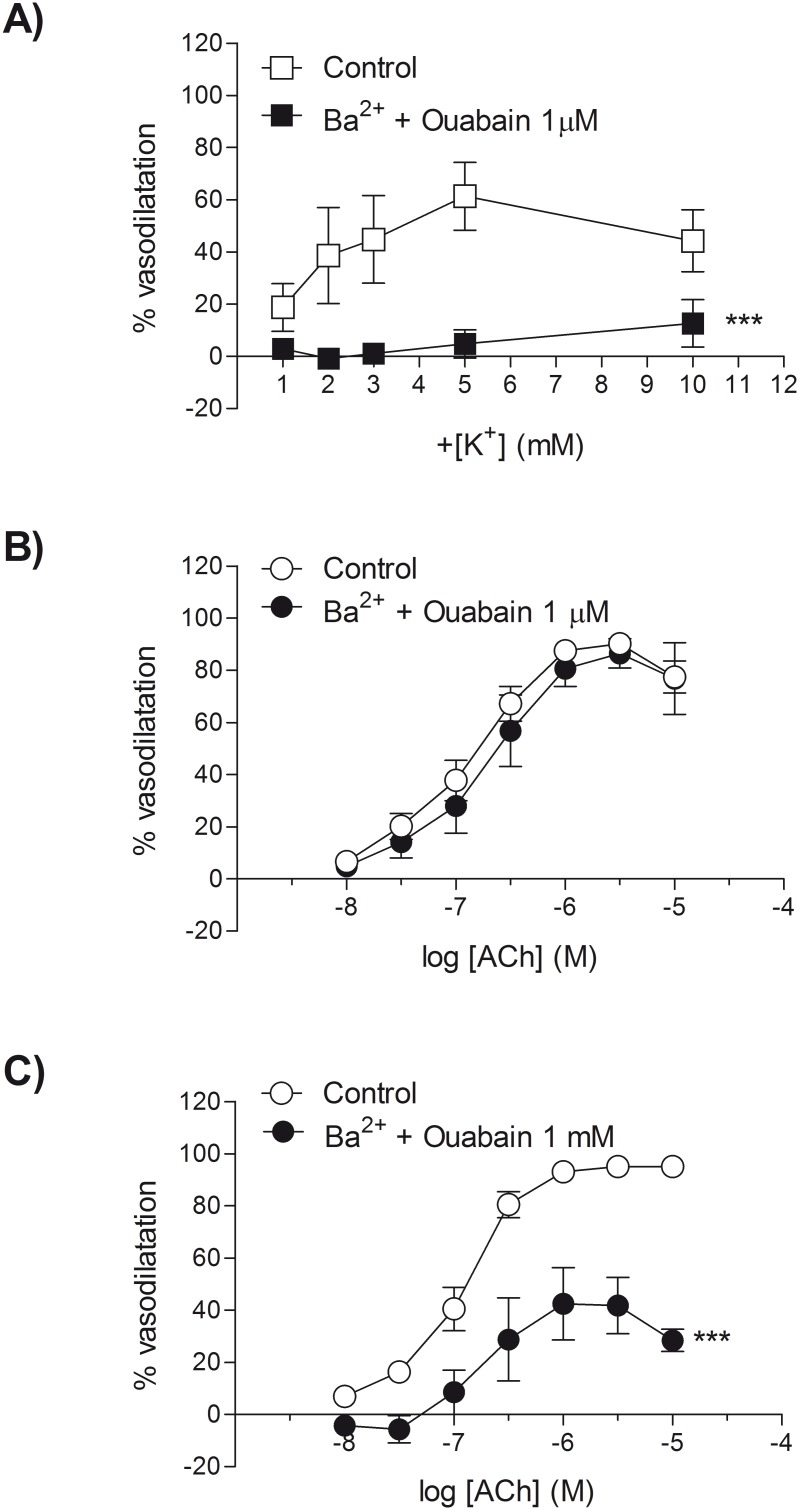
Responses to raised extracellular potassium are sensitive to the combination of barium and ouabain.The effect of Ba2+ (30 µM) and ouabain (1 µM or 1 mM) on responses to raised extracellular potassium (A) in rat isolated mesenteric small arteries at 90 mmHg. Responses to ACh in the presence or absence of Ba2+ (30 µM) and ouabain (B: 1 µM or C: 1 mM). All experiments were carried out presence of L-NAME (100 µM and indomethacin (1 µM). Each point represents the mean ± s.e.mean. ***P<0.001, Ba2+ and ouabain treated versus control, n = 5.